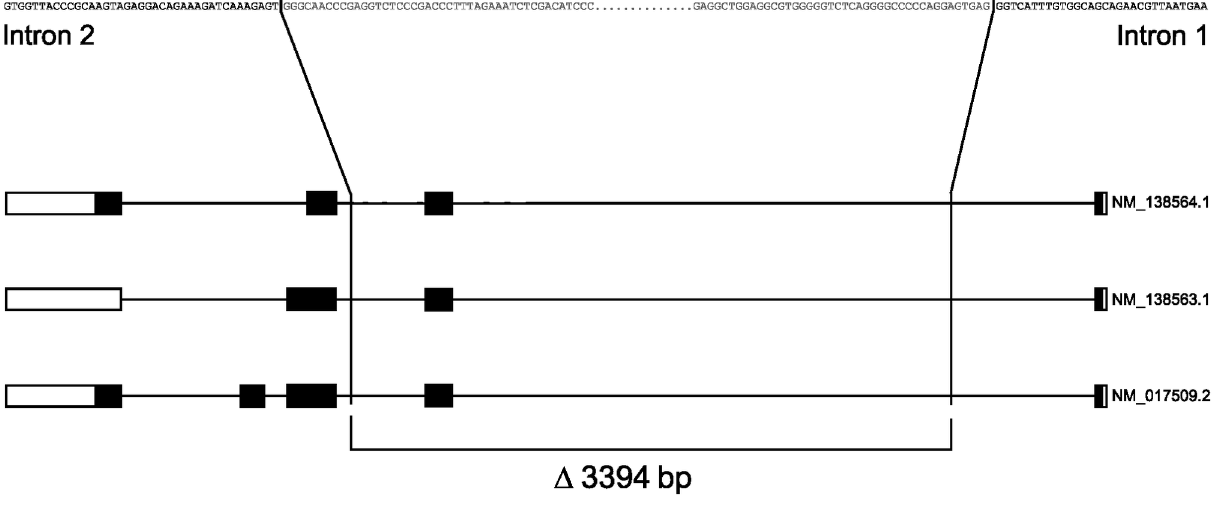
Figure 3. Location of the breakpoint sequences of the deletion in the KLK15 gene. The deletion in the KLK15 gene is located between nucleotide 56 022 311 in intron 2 and nucleotide 56 025 704 in intron 1 of the KLK15 gene, which results in a 3394-bp deletion eliminating exon 2. doi: